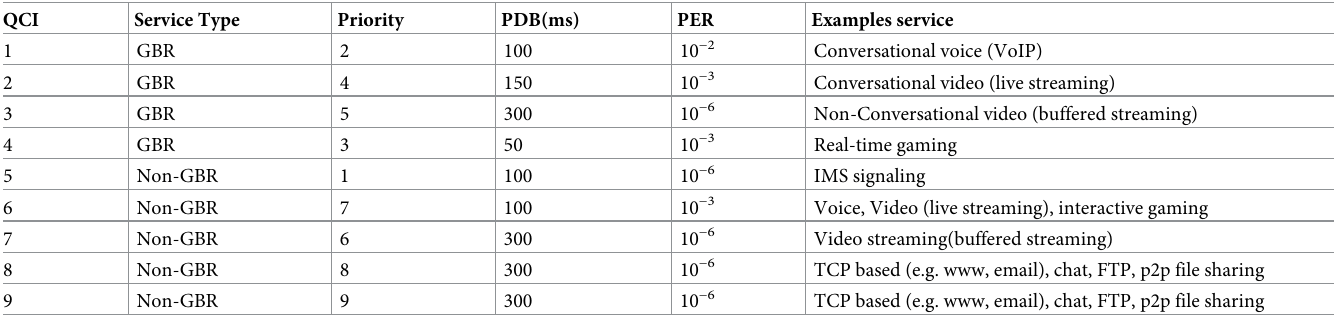
Table 2. Standardized QCI